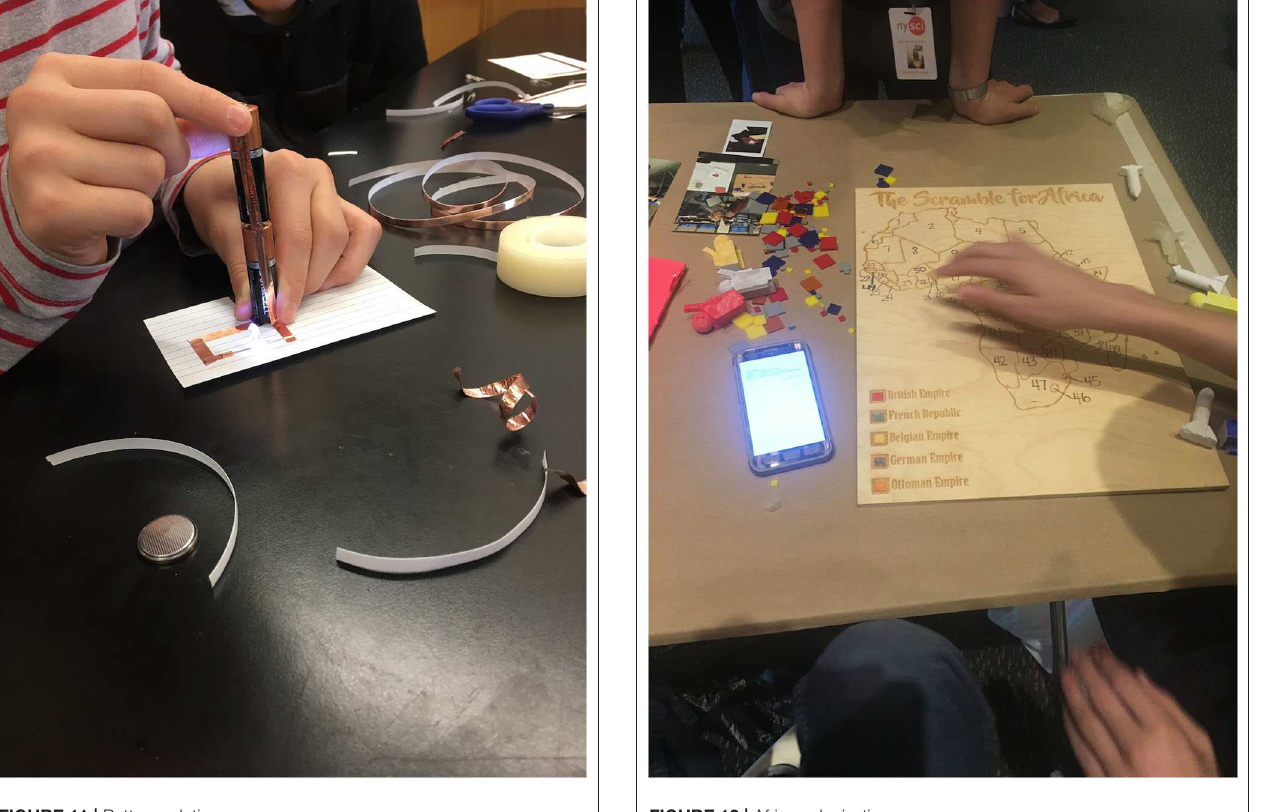
FIGURE 11 | Battery solution. FIGURE 12 | Africa colonization